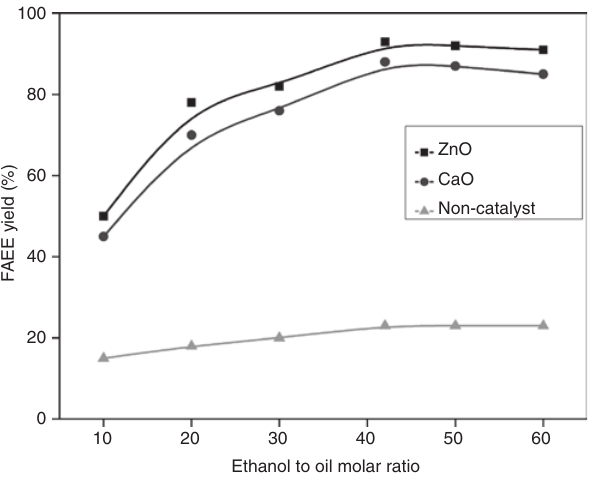
Figure 15: Effect of molar ratio at reaction conditions: temperature 270 ° C, 60 min and 3 wt% catalyst